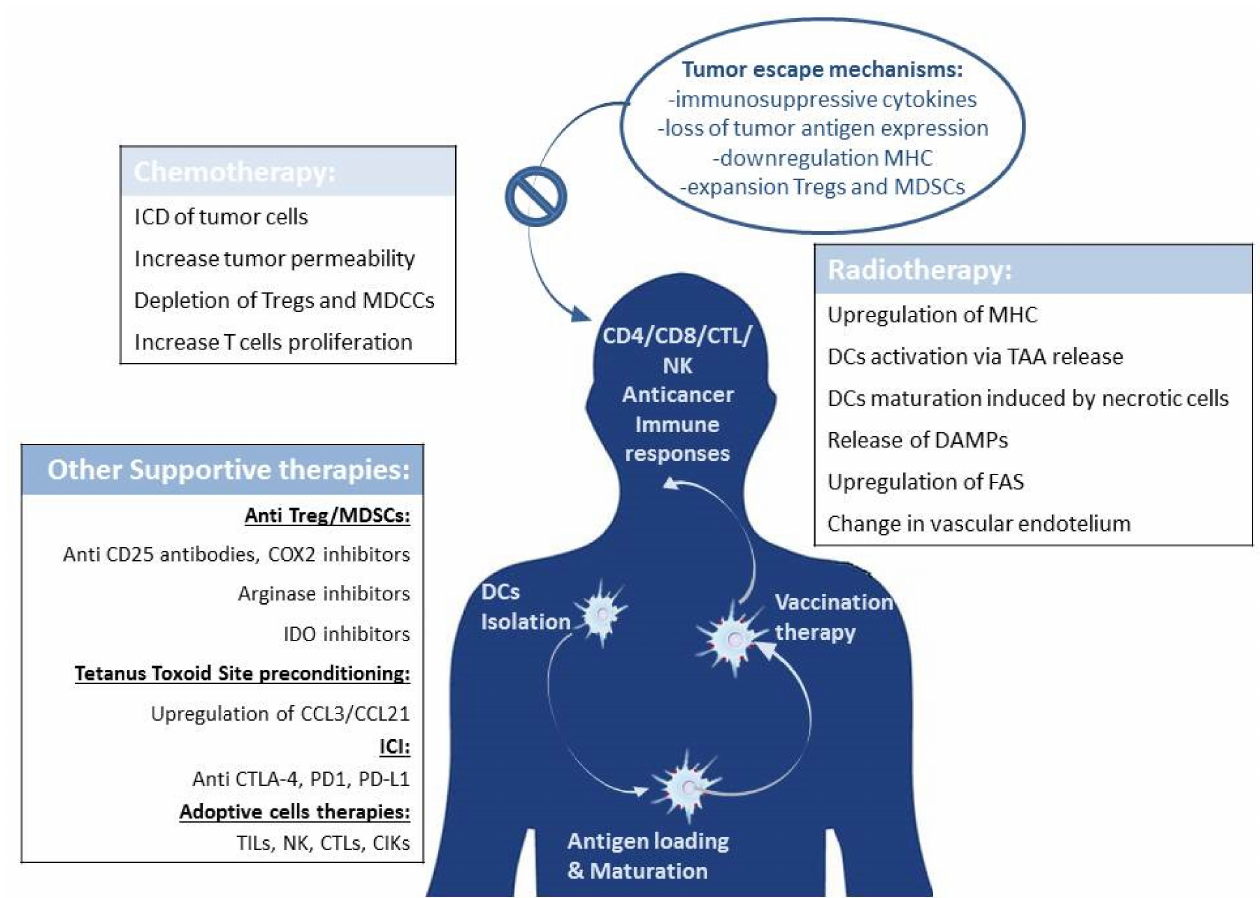
Figure 1. Combined therapy. Tumor escape mechanisms often inhibit the effect of dendritic cell vaccination. Conventional therapies such as chemo/radiotherapy can collaborate with DCs vaccination, promoting the activation of immune cells effectors and hampering the functions of immunosuppressive cells. Other innovative strategies are under investigation as a support to contrast tumor immune escape, such as inhibitors of Tregs and MDSCs; ICI, adoptive cells therapies and preconditioning of the pre-vaccine injection